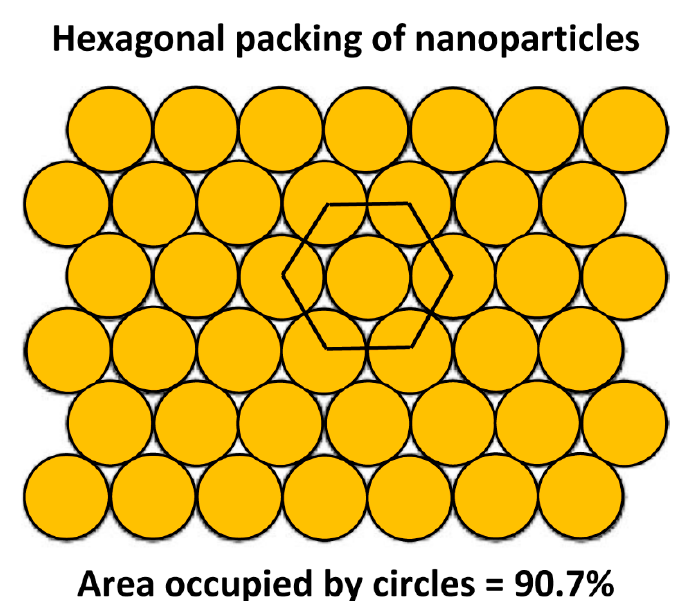
Figure 12. Hexagonal packing of nanoparticles.